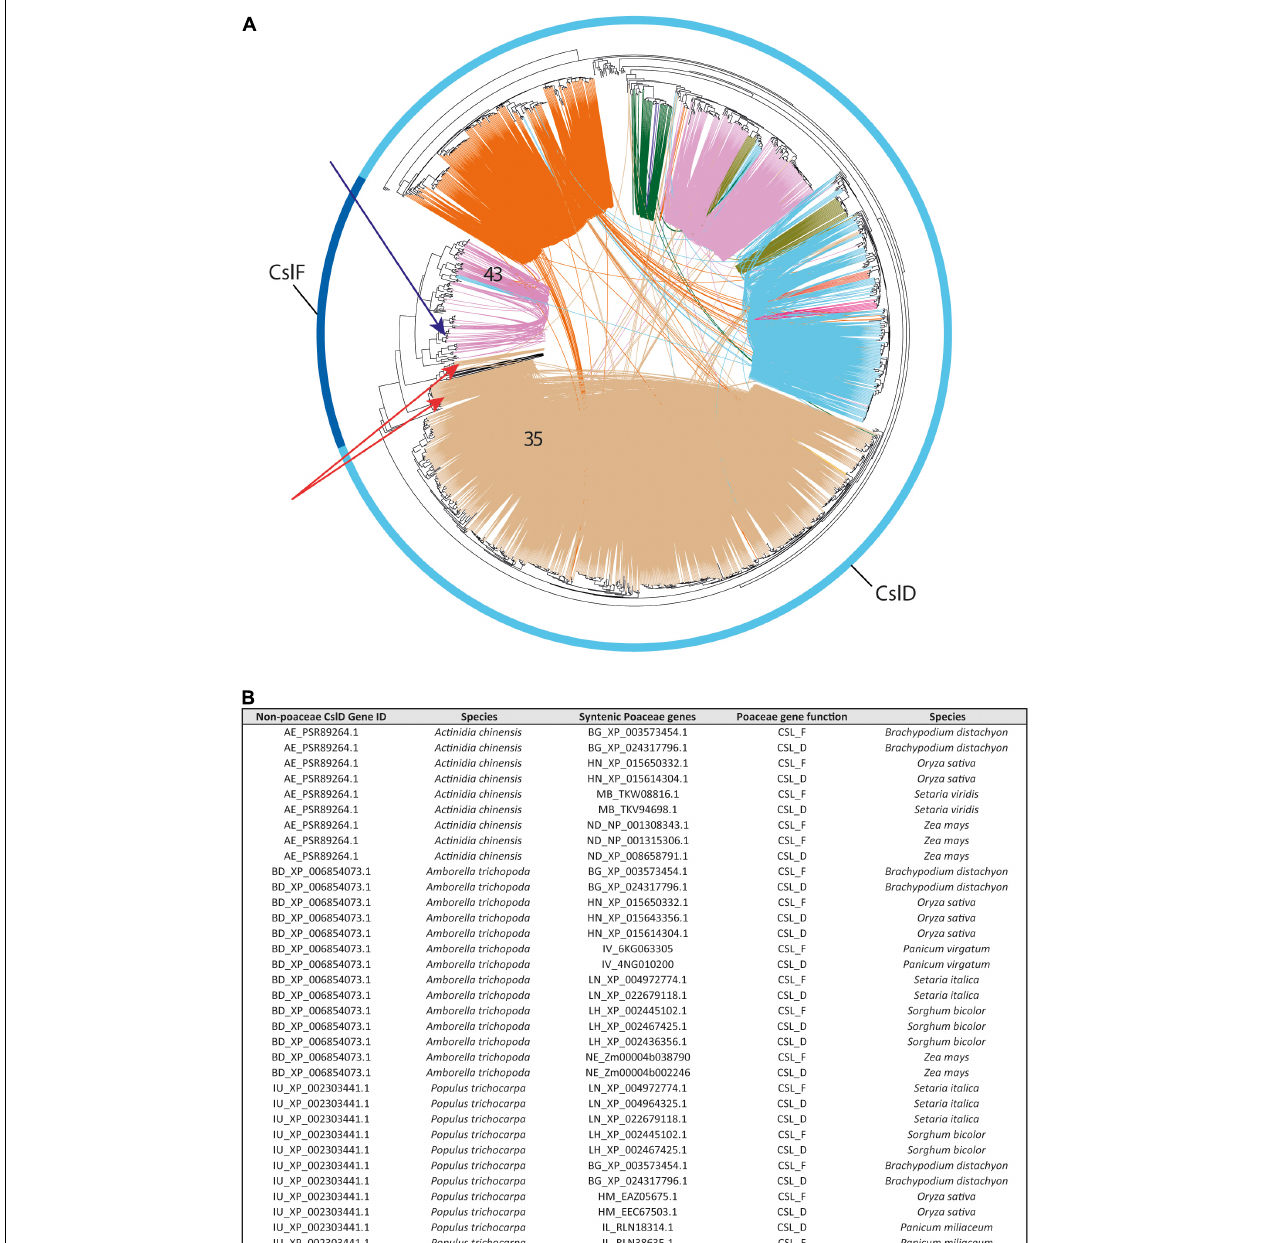
FIGURE 6 | The 1:2 syntenic connections between a group of angiosperm CslD genes and a class of Poaceae CslD and CslF genes. (A) Phylogenetic tree of all the CslD and CslF genes from the 193 genomes with a BUSCO representation ≥ 75% and at least five genes per scaffold on average. The outer ring highlights CslD and CslF tree branches. Red arrows indicate the CslF genes syntenic to CslD isoforms involved in root morphology (same syntenic community as in Figure 4 ). Blue arrow indicates the positioning of HvCslF3 and HvCslF10 , the two CslF genes responsible for the synthesis of 1,4- β -linked glucoxylan in barley. (B) Table reporting examples of syntenic connections between three CslD genes from three different angiosperm species and both CslF and CslD genes across different Poaceae species.